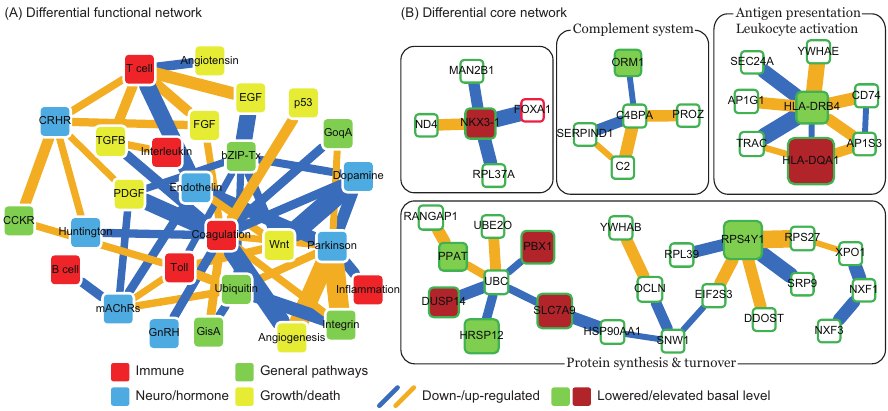
Figure 3. Differential functional and core networks for Stage II to III. ( A ) Differential functional network. Node colors indicate the biological significance of the enriched functions. Red: immune; blue: neuro/hormone; green: general pathway; yellow: growth/death. Link colors indicate changes in interaction ability from Stage II to III. Blue: down-regulated; orange: up-regulated. Link width indicates the absolute value of the difference in interaction ability from Stage II to III; ( B ) Differential core network. Node colors indicate changes in basal level, representing changes in miRNA and methylation regulations from Stage II to III. Green: lowered; red: elevated. Link colors indicate changes in interaction ability from Stage II to III. Blue: down-regulated; orange: up-regulated. Link width indicates the absolute value of the difference in interaction ability from Stage II to